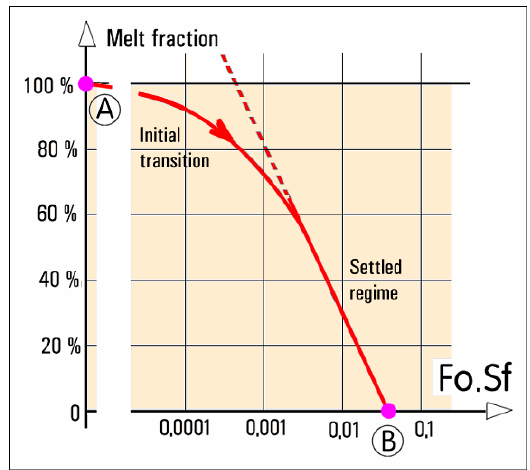
Fig. 16. Expected character of measured data on the solidification inside the spherical capsule model after their conversion into dimensionless dependence in semi-logarithmic co-ordinates . Essential part of the plotted curve is exponential (and therefore a shown here as straight line). Very little is so far known about the very short time of initial transition.